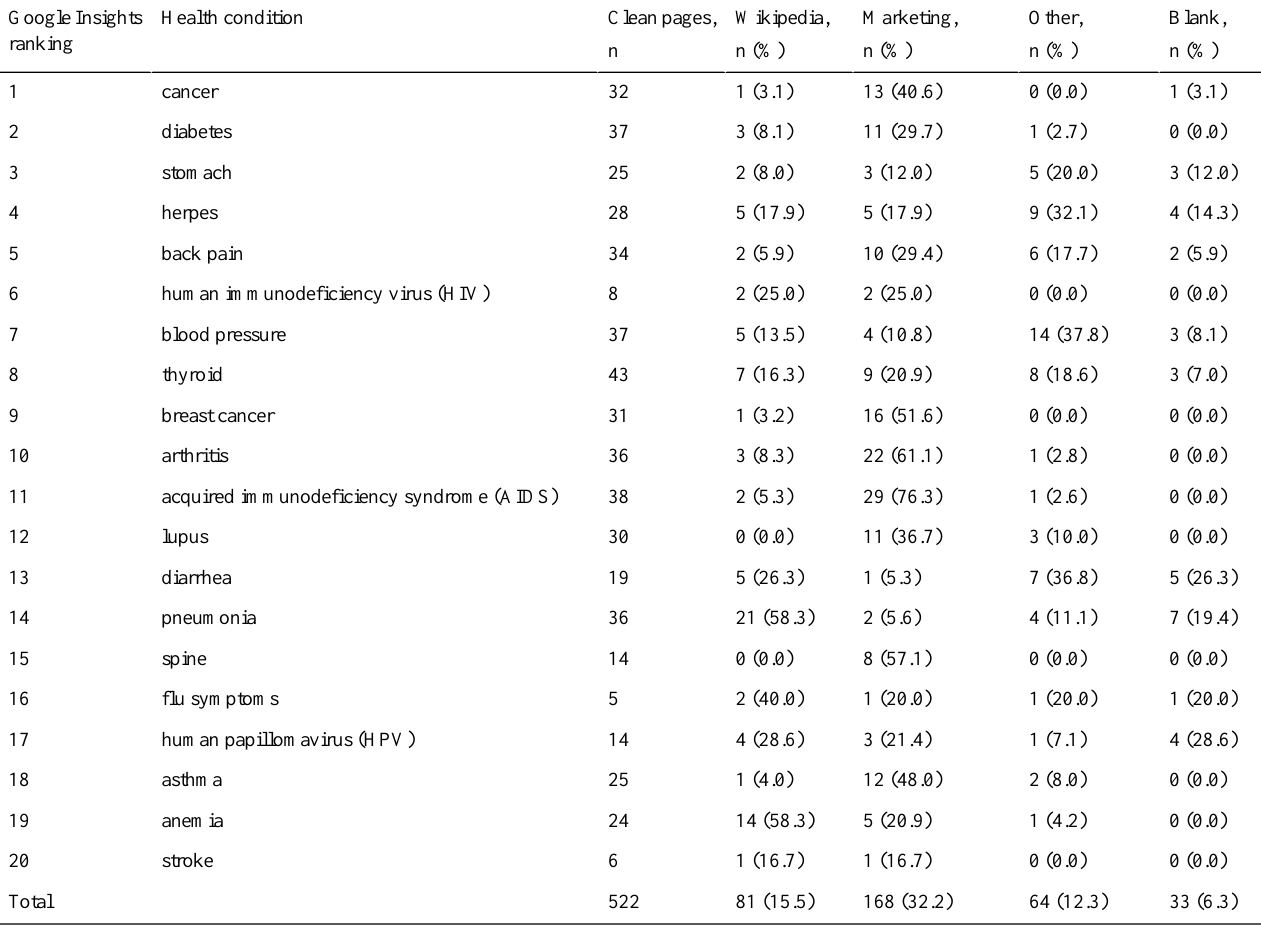
Table 5. Facebook pages by health condition and content—Wikipedia, Marketing, Other, and Blank.